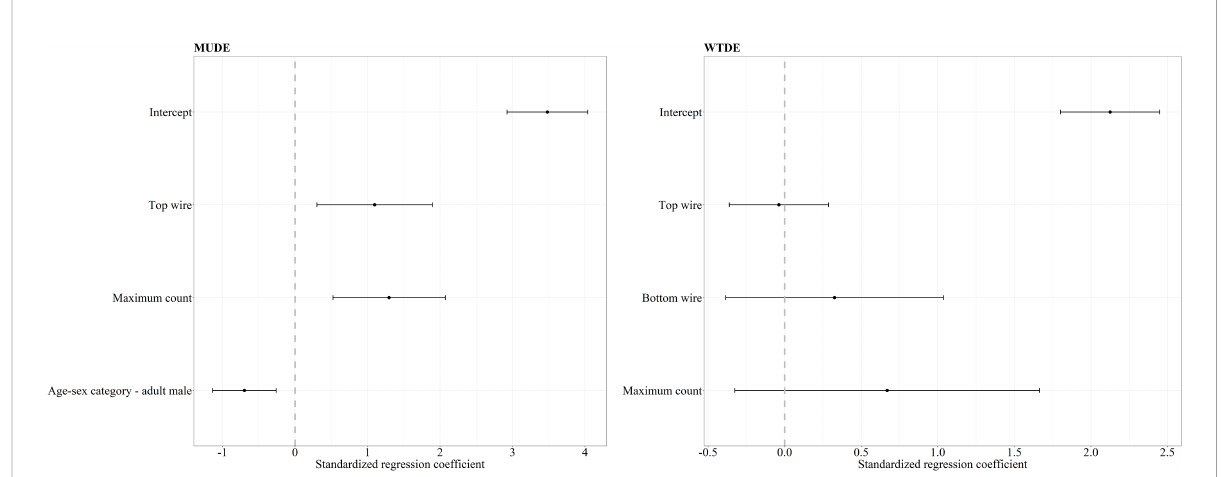
FIGURE 1 Standardized regression coef fi cients and 95% CI for the top models of crossing success of mule deer (MUDE) and white-tailed deer (WTDE). The regression coef fi cient for the white-tailed deer success was averaged between four competing models with D AICc < 2.0 whereas our mule deer mixed effects logistic regression resulted in one top model. We considered bottom wire height, area (reference category – AB), sex-age (reference category – adult female), maximum count, snow (reference category – absent), and treatment-period (reference category – control- before) as covariates in our mixed effects logistic regression analysis. Covariates whose 95% CI overlap 0 are considered